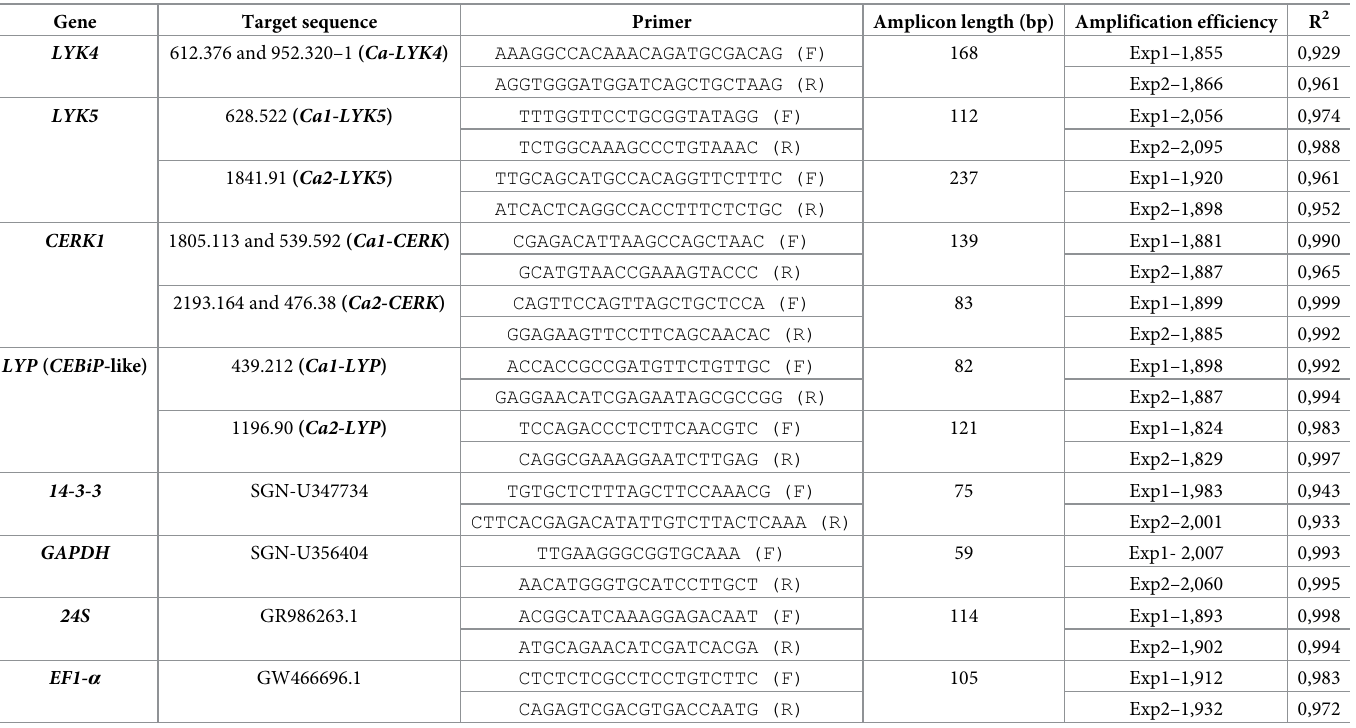
Table 2. Sequence of primers used for candidate sequences of C . arabica PRRs and reference genes. Gene Target